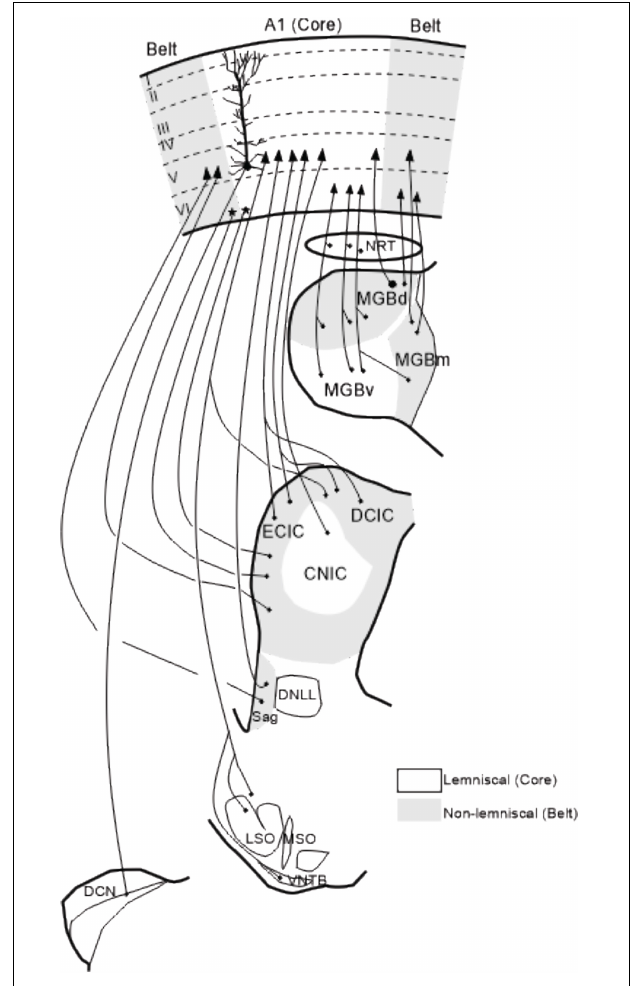
FIGURE 4 | Summary of corticofugal projections to auditory nuclei. Corticofugal projections to the nucleus reticularis thalamic, auditory thalamus and Sagulum are ipsilateral whereas projections to the inferior colliculus, superior olivary complex and cochlear nucleus are bilateral although predominantly from the same side. Modified from Winer (1992) and Malmierca et al. (2015). The details of these corticofugal projections are described in the following papers: Beyerl (1978); Adams (1980); Druga and Syka (1984a,b); Faye-Lund (1985); Feliciano and Potashner (1995); Saldaña et al.